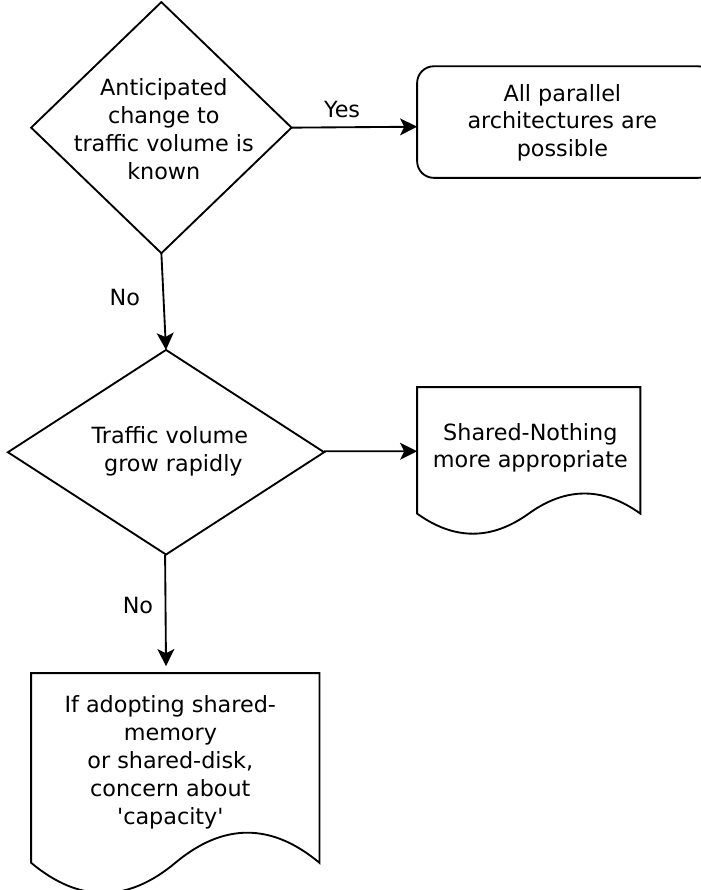
Figure 4. Choosing parallel architectures based on anticipated changes to traffic